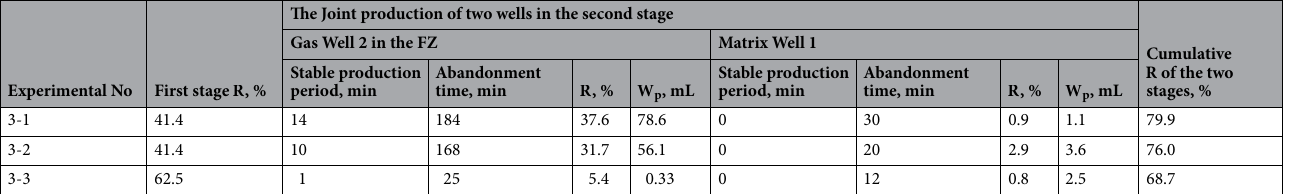
Table 9. Statistics on the production of Group III.